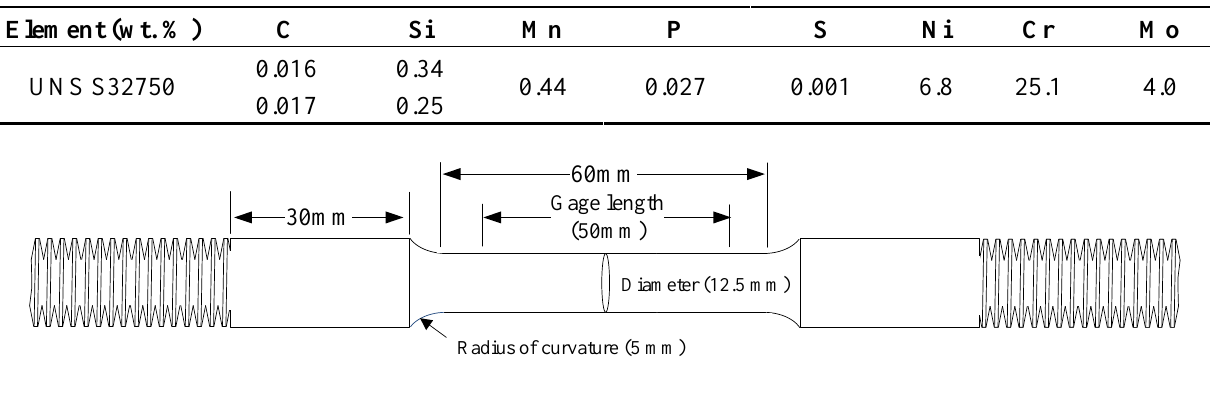
Figure 1. The dimension of the tensile test specimen (KS B0801 10).